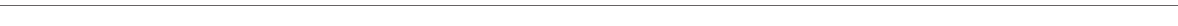
FigUre 6 | GITR–GITR-L interaction results in increased ILC1 functionality in the course of H1N1 infection. Wild-type mice were treated with either DTA-1 GITR agonist/isotype (500 µg/animal) or GITR-Fc fusion chimera protein (6.25 µg/animal) i.p. After 24 h mice were infected i.n. with 2 × 10 3 ffu of the H1N1 PR8 strain. (a) Representative histograms and MFI of GITR expression by ILC1s. Lung-derived lymphocytes of infected wild-type mice 3 dpi were incubated at 37°C in medium containing brefeldin and monensin for 3 h prior to the flow cytometry staining with regard to markers related to ILC1 activation and functionality. (B) MFI and frequencies of lung-derived ILC1s expressing IFN- γ , TNF- α , and TRAIL from DTA-1-treated and control groups. (c) MFI and frequencies of lung-derived ILC1s expressing IFN- γ , TNF- α , and TRAIL from GITR-Fc-treated and control groups. Shown is one out of two independent experiments ( n = 4–6). Box plots represent MFI and range in frequencies with the horizontal line drawn at the mean. Asterisks denote significant values as calculated by One-way ANOVA; **** p ≤ 0.0001; *** p ≤ 0.001; ** p ≤ 0.01; * p ≤ 0.05; n.s., not